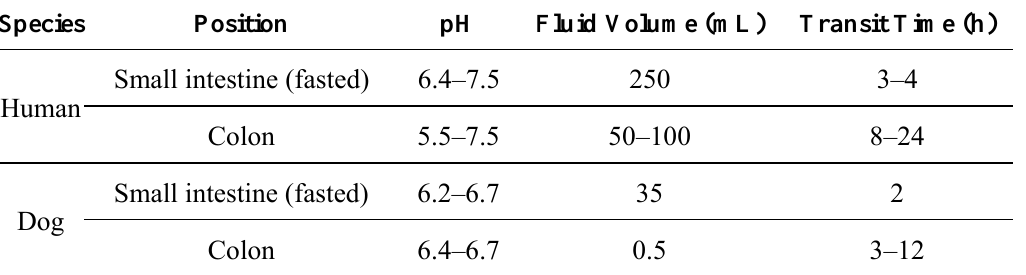
Table 1. Comparison of the properties of the small and large intestines in humans and dogs